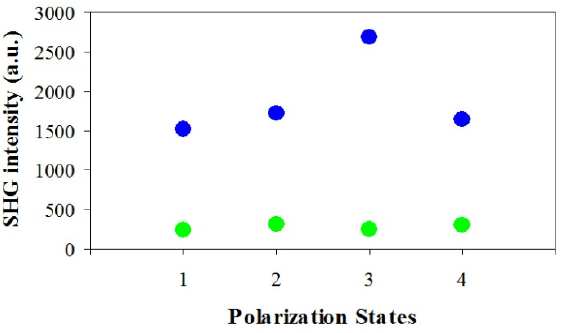
Figure 9. SHG intensity values for the SHG images of the precedent figure (blue, upper panels; green, bottom panels).